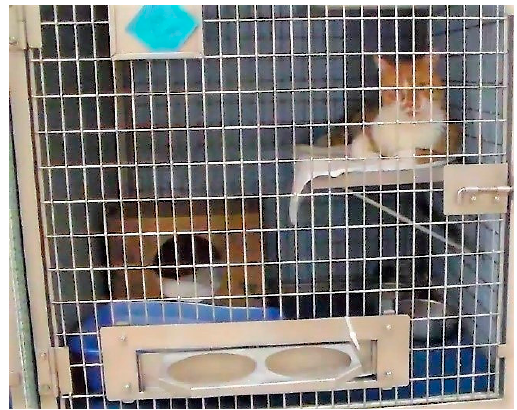
Figure 1. Study cat during confinement showing cage set-up.